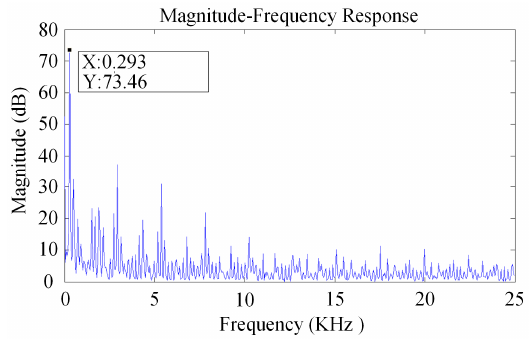
Figure 3. Frequency response of driving interference for micro gyroscope.